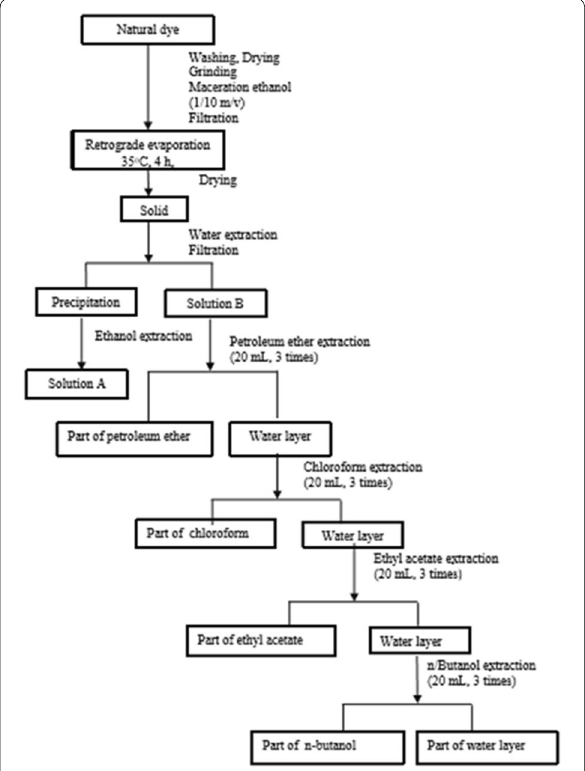
Fig. 8 Purification scheme of the extracts recovered from Mortiño fruit and Jamaica